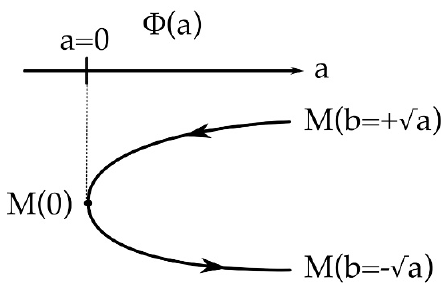
Figure 3 . The variation of an associative three-cycle M ( b ) inside a G 2 -manifold, with G 2 -form (cid:8)( a ). The variation is shown with respect to the parameter a under the constraint b 2 = a , required for M ( b ) to be an